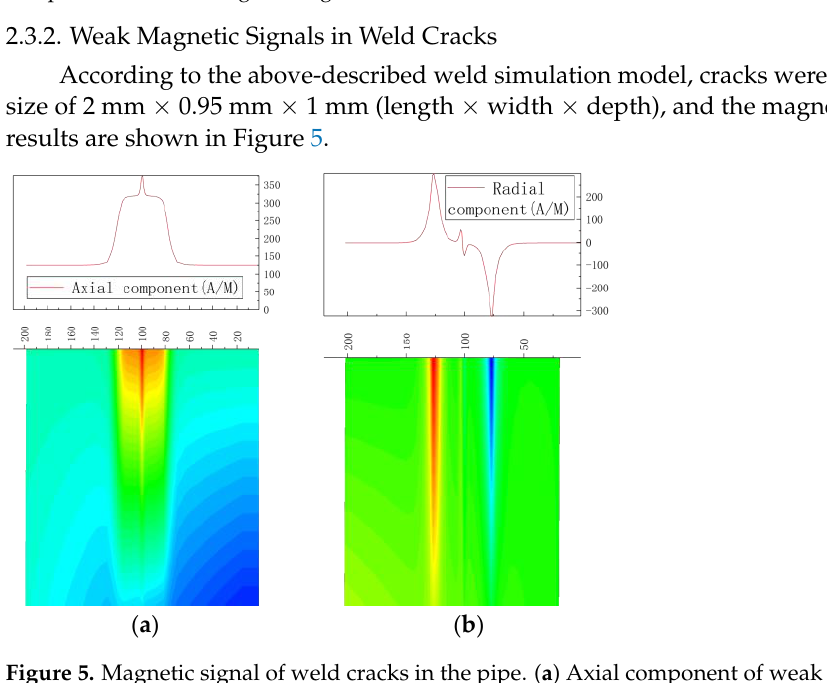
Figure 5. Magnetic signal of weld cracks in the pipe. ( a ) Axial component of weak magnetic signal; ( b ) radial component of weak magnetic signal.